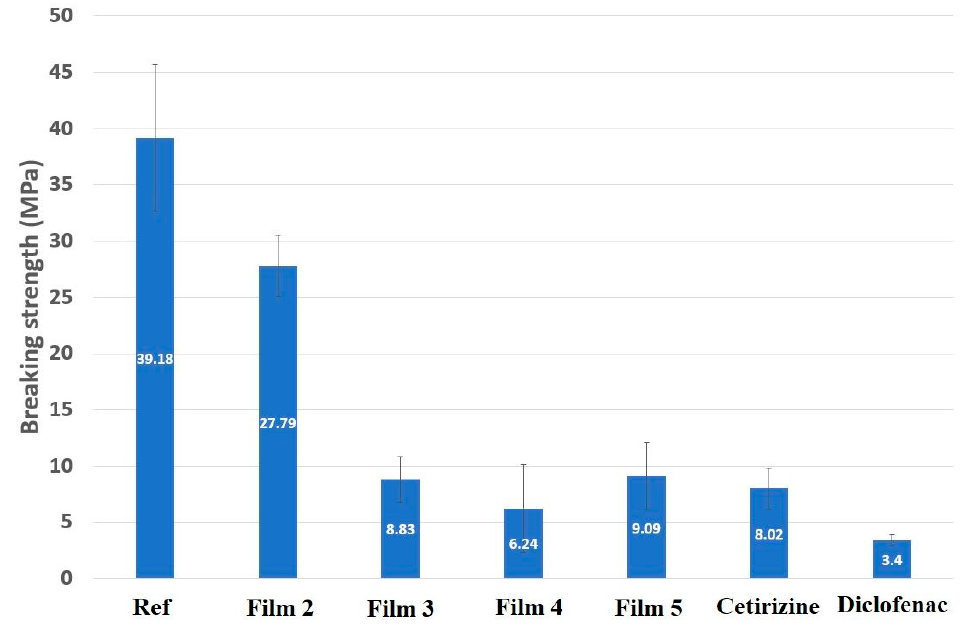
Figure 2. Breaking strength results in combination with acetic acid for chitosan films made with different concentrations of ascorbic acid and films containing cetirizine HCl and diclofenac Na.